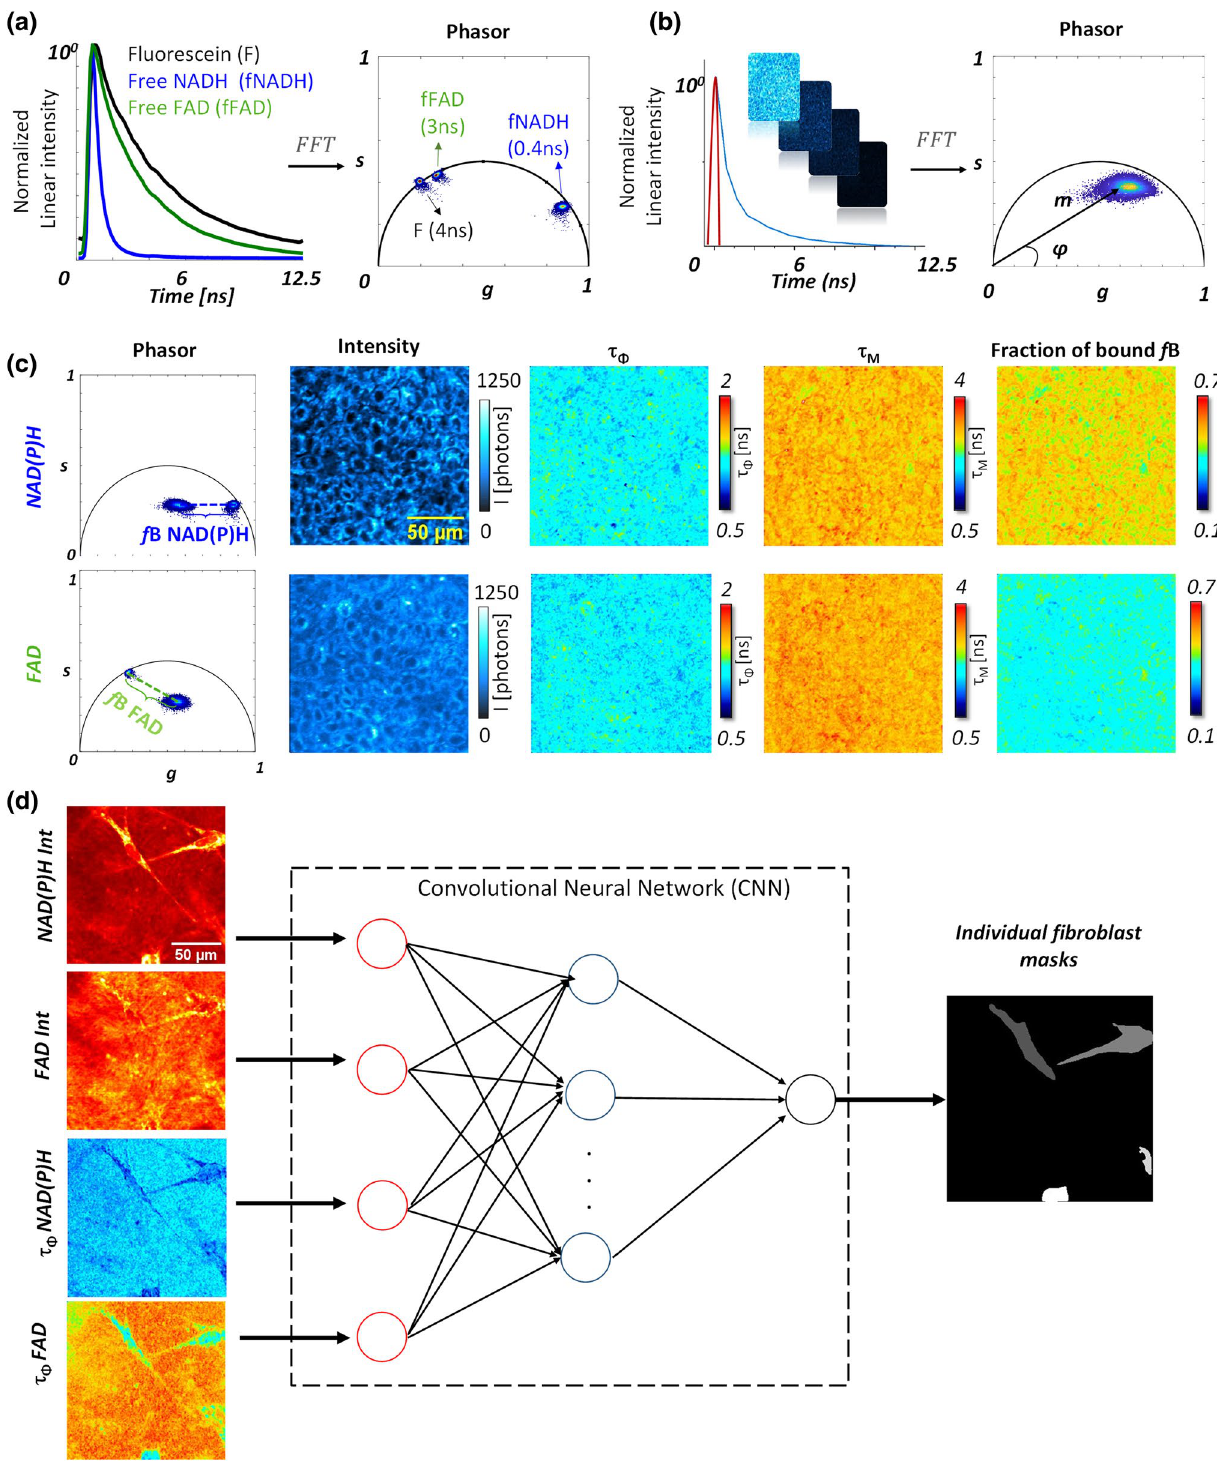
Figure 2. Image processing workflow for FLIM phasor analysis and single fibroblast segmentation with deep learning. ( a ) FFT based phasor analysis of FLIM images of fluorescein (F), free NAD(P)H (fNAD(P)H) and free FAD (fFAD) solutions with 4 ns, 0.4 ns and 3 ns lifetimes respectively. ( b ) Example of phasor analysis of the NAD(P)H FLIM image of keratinocytes within the stratum basale of T-Skin model. Every fluorescence decay (e.g. blue curve) of every pixel of the image is represented by a pixel in the phasor plot with g and s coordinates. The red curve indicates the instrumental response function. ( c ) Calculation of phase lifetime (τ Φ ), modulation lifetime (τ M ) and fraction of bound ( f B) parameters of NAD(P)H and FAD based on g and s phasor FLIM parameters. The fractions of bound NAD(P)H and respectively bound FAD are calculated from the distances between the phasor plots of free NAD(P)H and respectively free FAD solutions to the mixed sample phasor plots of free / bound NAD(P)H and respectively free / bound FAD. ( d ) Workflow of single-fibroblast segmentation by deep learning with multi-modal images. Four inputs are given to the deep learning network: intensities and lifetimes of NAD(P)H and FAD. The output of the network provides a mask for every single